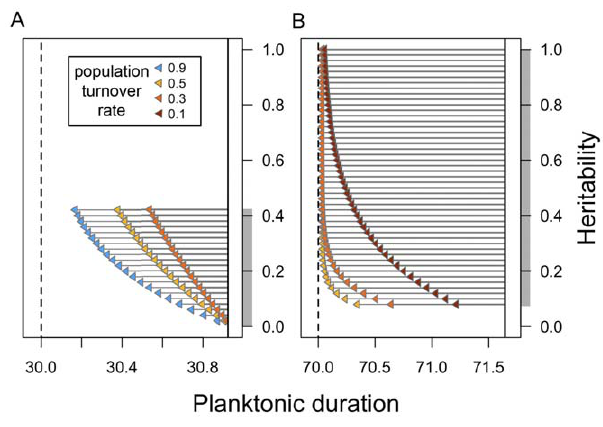
Figure 3. Summary of simulated evolution over 50 years, using different underlying heritabilities and population turnover rates. Solid vertical lines indicate the estimated mean planktonic duration at elevated CO 2 , and dashed vertical lines indicate mean planktonic duration at ambient CO 2 , or the ‘target’ of selection, for ( A ) M. trossulus and ( B ) S. franciscanus . Grey shading along the y-axis shows the range of possible heritabilities given maternal-effect heritability of 0 to 100%. Arrowheads indicate the mean phenotype after 50 years of evolution, and arrow lengths indicate the change in mean phenotype from the initial mean phenotype towards the target of selection. Population turnover rates used in simulations are shown in colour. Higher turnover rates are shown for M. trossulus (0.3–0.9) compared to S. franciscanus (0.1–0.5) to reflect known differences in species’ demography (see methods).